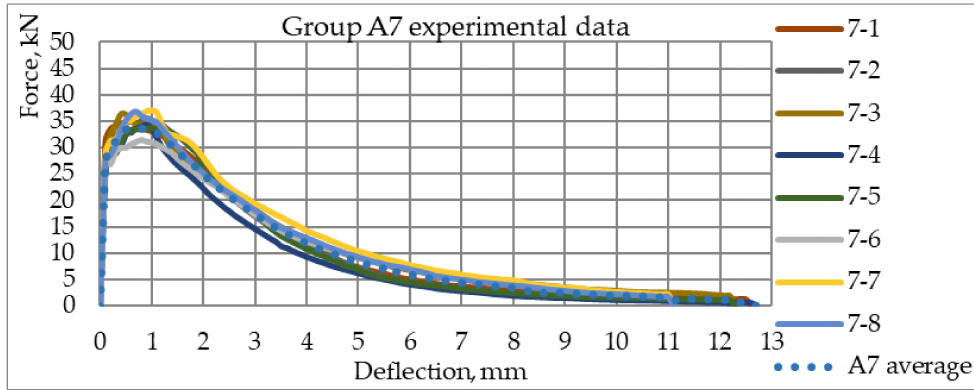
Figure 21. Load—sample center vertical deflection graphs for the specimens in Group